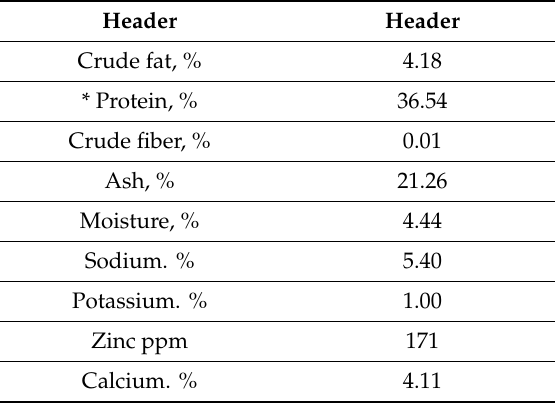
Table 2. Chemical composition of NG concentrate.